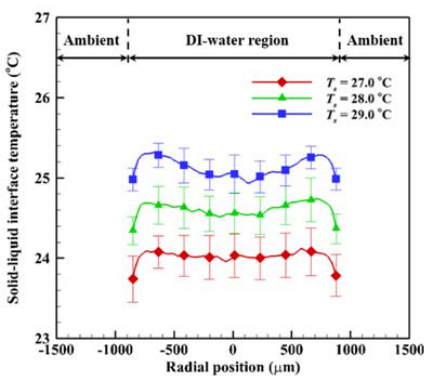
Figure 8. Solid–liquid interface temperature distribution along the line of AB.